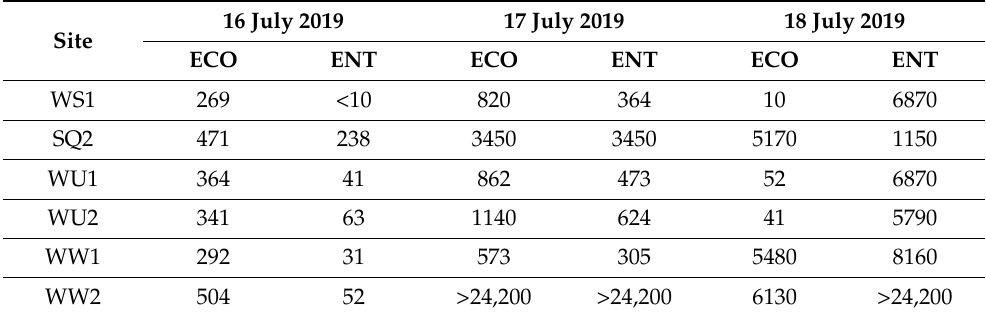
Table 5. FIB concentrations (cfu/100mL) at sites from the Utica region from 16 July to 18 July; 17 July included an active CSO between WW1 and